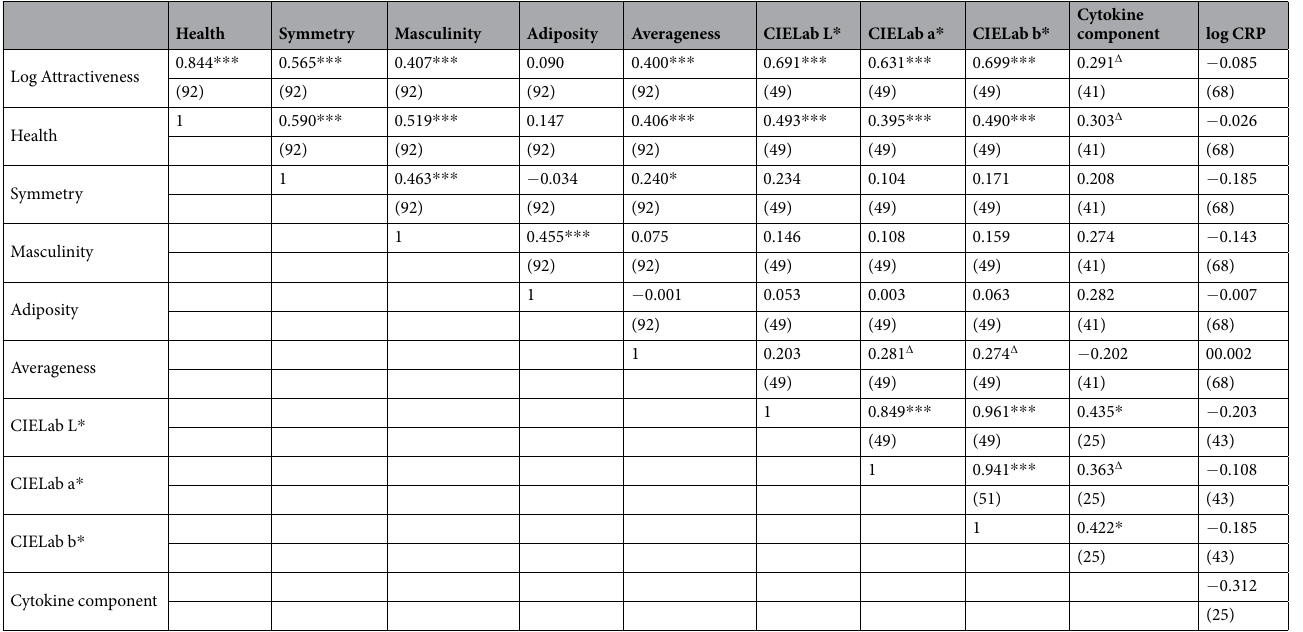
Table 1. Pearson’s correlations between attractiveness and health, facial cues, skin colour, cytokine component and CRP. ∆ p < 0.1, * p < 0.05, ** p < 0.01, *** p < 0.001. N in